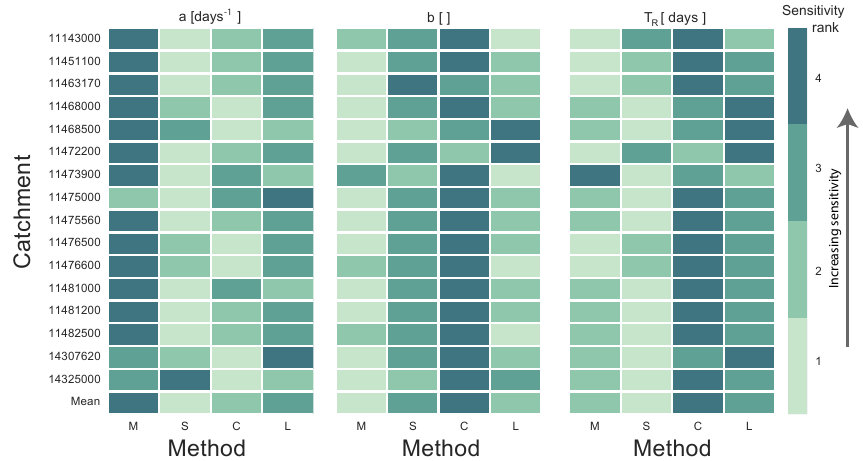
Figure 9. Box plots comparing recession exponent shared vs. unshared distributions for minimum recession length and concavity method choices for Elder Creek. Each subplot corresponds to a particular method choice; the shared boxes are generated with the b values from the recessions shared between the more and less restrictive values of the method choice for that subplot. The unshared boxes are those values of b from the recessions extracted by only the less restrictive value of the subplot method choice. The independent axis enumerates the eight combinations of the method choices other than the subplot method choice.